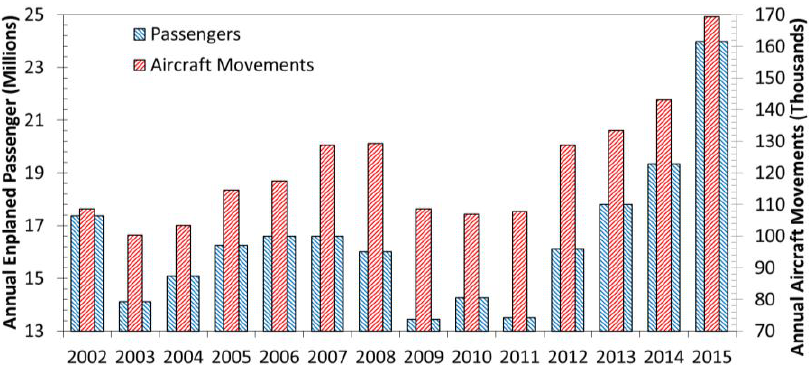
Figure 1. Annual enplaned passengers and aircraft movements (both domestic and international) at Kansai International Airport: 2002 to 2015. Source: Data derived from [64,65].